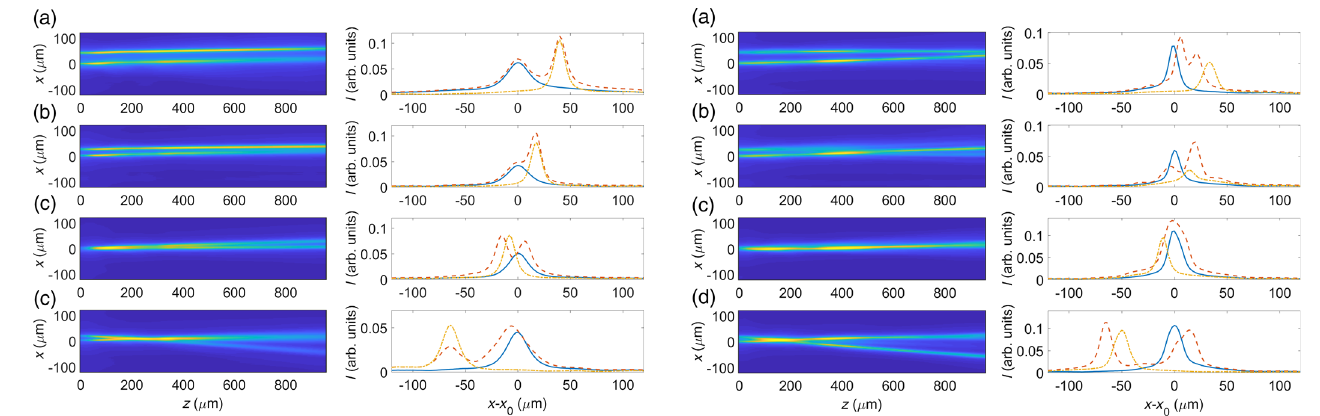
FIG. 7. Two-beam interaction with only the geometric phase. (a) – (c) Interaction of two parallel optical beams separated by a distance of (a) 40 μ m, (b) 20 μ m, and (c) 0 μ m. In (d) the upper beam is tilted in order to achieve an X-junction configuration. The first column illustrates the intensity distribution on the observation plane xz , whereas the second column reports the intensity cross section at z ¼ 960 μ m when the two beams are launched together (orange dashed lines) or when only the upper or the lower beam is launched alone (dot-dashed yellow and blue solid lines, respectively). In the right column, x 0 is the position of the lower beam when propagating alone. The input waist is 4 μ m, whereas the input powers are 50 mW for the top beam and 40 mW for the bottom beam.